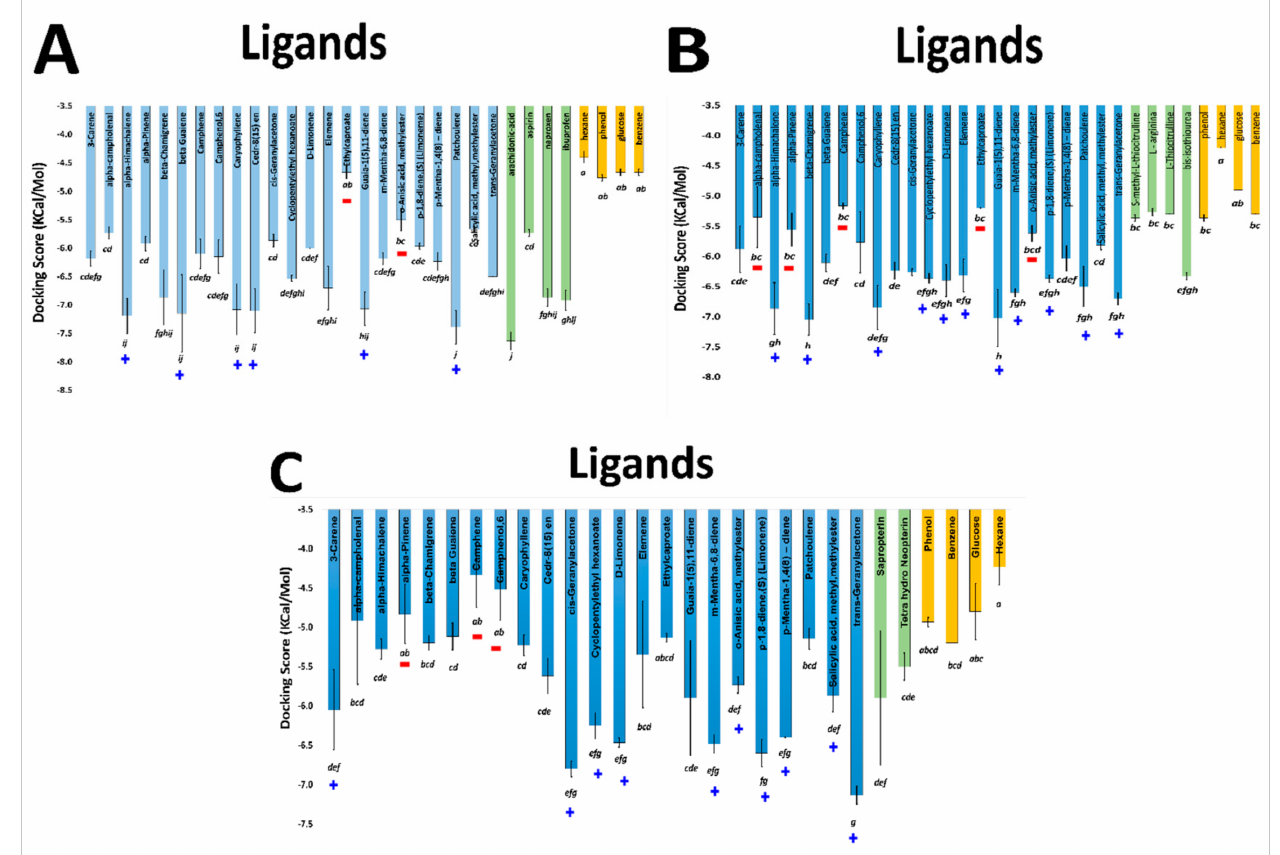
Figure 3. Average docking scores for the three first poses of the respective aroeira compounds and controls at the three targeted sites. ( A )—COX-1; ( B )—iNOS active site (iNOSas); ( C )—iNOS cofactor site (iNOScs). Bars are colored in blue for the aroeira compounds, green for positive controls and yellow for negative controls. Letters below the bars indicate the grouping of the scores according to ANOVA. A blue “plus” (+) and a red “minus” ( − ) symbols indicate, respectively, top and worst hits between the aroeira volatiles for each site at each